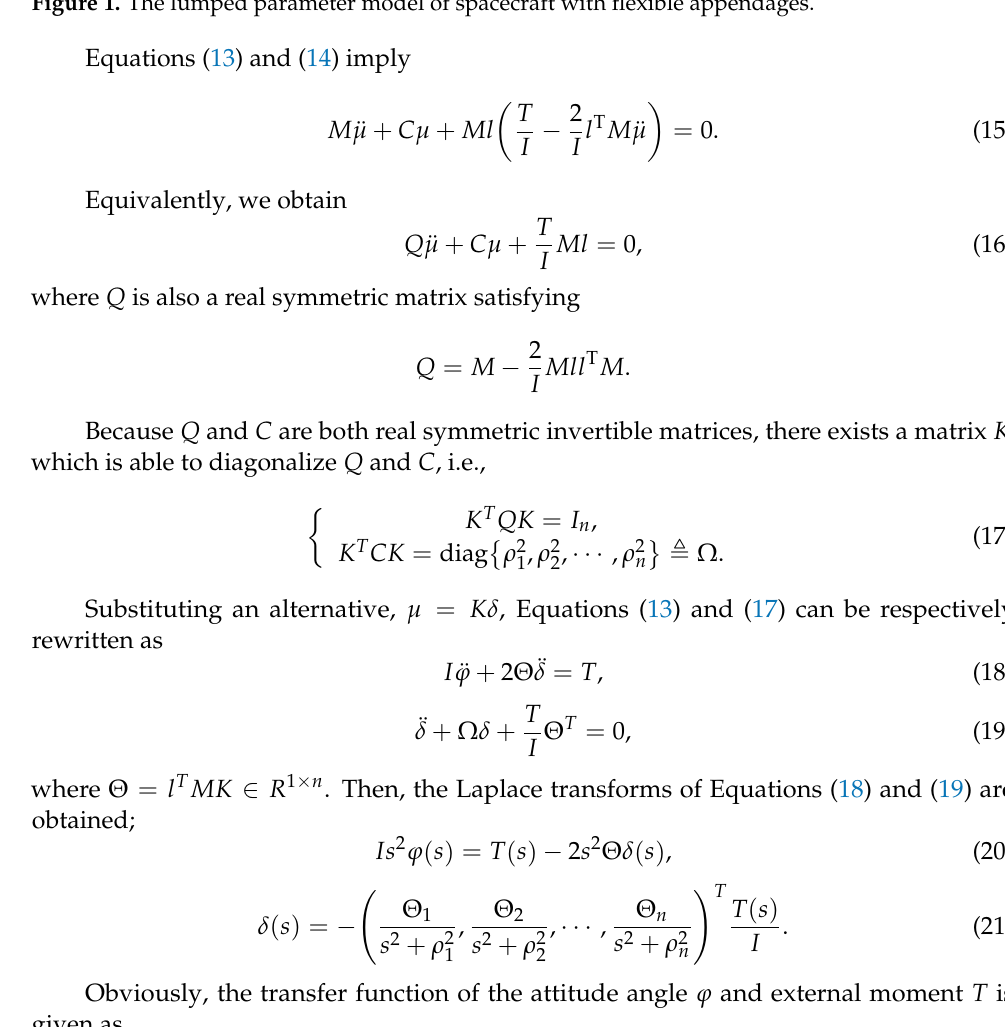
Figure 1. The lumped parameter model of spacecraft with flexible